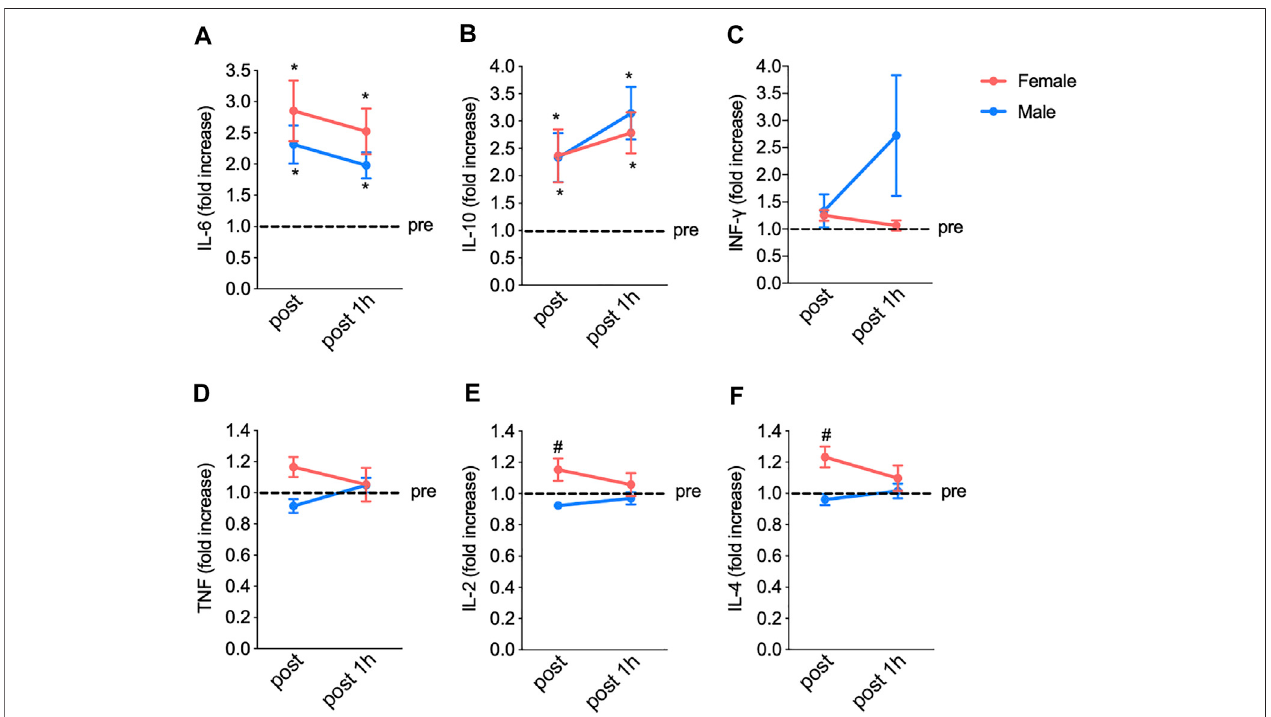
FIGURE4| ThefatiguingexerciseprotocolresultsinincreasedinterleukinIL-6 (A) andIL-10 (B) levelsimmediatelyaftertheexercisecomparedtopre-testvaluesin both groups.Nosigni fi cantchangesinINF γ (C) ,TNF α (D) ,IL-2 (E) ,and IL-4 (F) concentrationswereobserved. Dataareshownasmeansandstandarddeviations,with p < 0.05 indicating statistical signi fi cance. IFN, interferon; TNF, tumor necrosis factor; IL, interleukin.